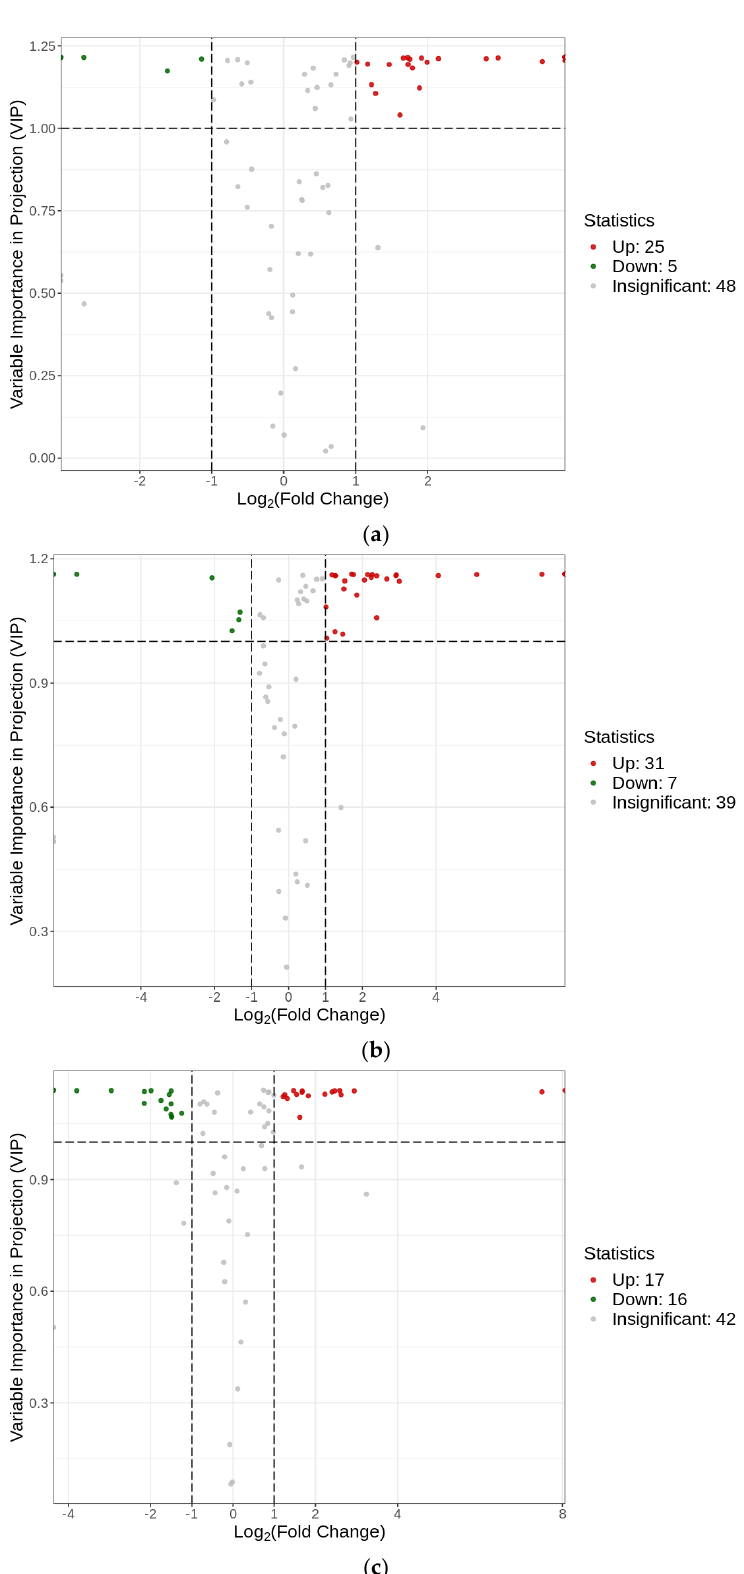
Figure 5. Volcano maps of differential metabolites. ( a ) GZ2 vs. CK; ( b ) GZ4 vs. CK; ( c ) GZ4 vs.